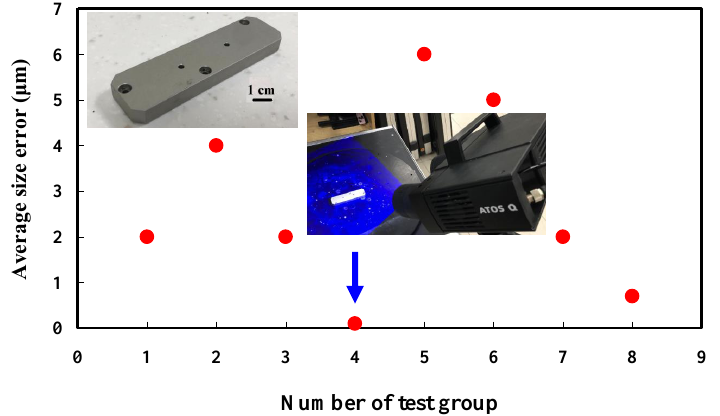
Figure 11. Average size error of the eight test groups compared to conventional method for the cast part after CNC machining.